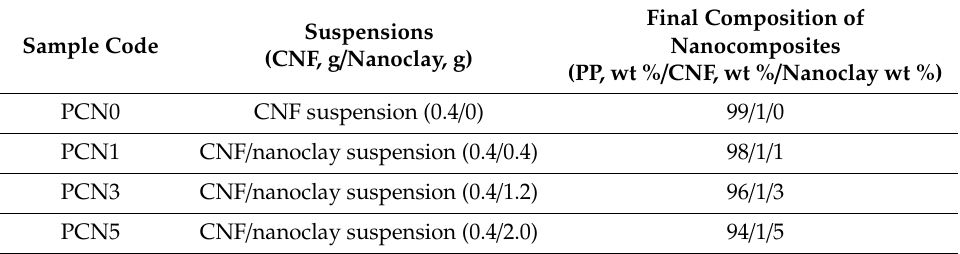
Composition of the polypropylene (PP) / cellulose nanofiber (CNF) and PP / CNF / nanoclay